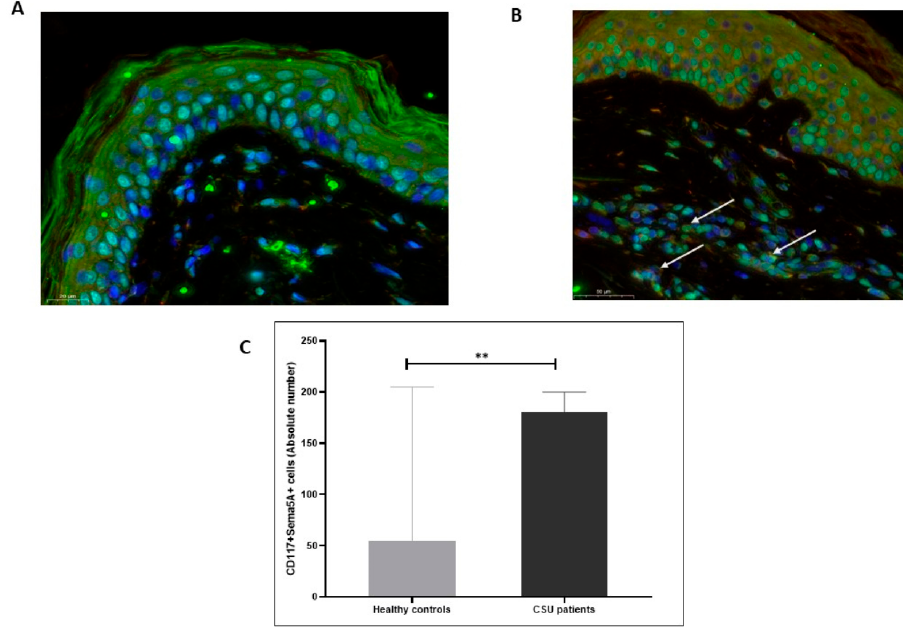
Figure 2. CD4+ T cells in the lesional skin of patients with CSU express Semaphorin5A. Sema5A is expressed by CD4+ T cells ( B , white arrows) in the skin of CSU patients compared to healthy controls ( A ). ( C ) shows the results of quantitative analysis of the double-staining of Sema5A/CD4+ T as evaluated by IMARIS software (as detailed in the “Methods” section). The pictures are 40 × magnification. **** statistically significance. Biomolecules 2020 , 10 , x FOR PEER REVIEW